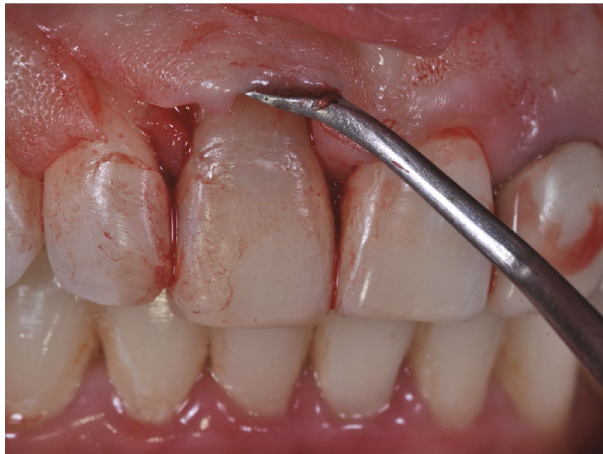
Figure 5: Incision made prior to extraction. Note that the papillae were